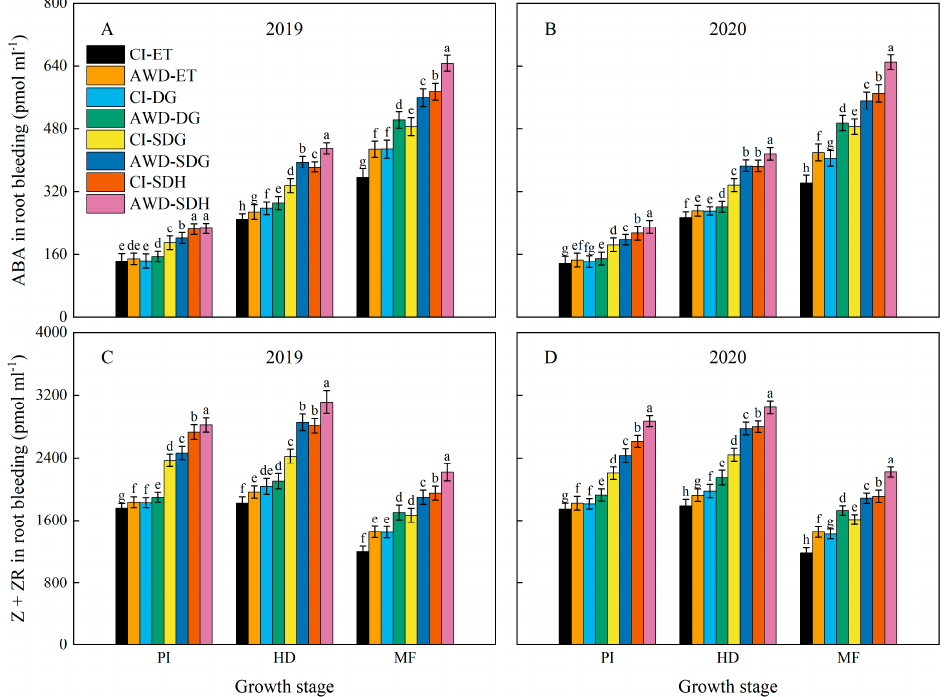
Figure 6. The content of abscisic acid (ABA) ( A , B ) and zeatin (Z) + zeatin riboside (ZR) ( C , D ) in root bleeding at three growth stages of mid-season indica rice genotypes under different irrigation treatments. CI and AWD represent conventional irrigation treatment and alternate wetting and drying irrigation treatments, respectively. ET denotes early tall genotype, DG denotes dwarf genotype, SDG denotes semi-dwarf genotype, and SDH denotes semi-dwarf hybrid. PI, HD, and MF represent panicle initiation, heading, and middle grain filling stage, respectively. Vertical bars represent ± standard error of the mean where these exceed the size of the symbol. Different letters above the columns indicate significant differences ( p ≤ 0.05) within the same measurement time.